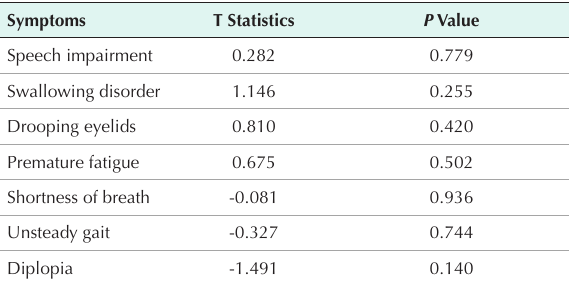
Table 6. Relationship Between Age and Disease